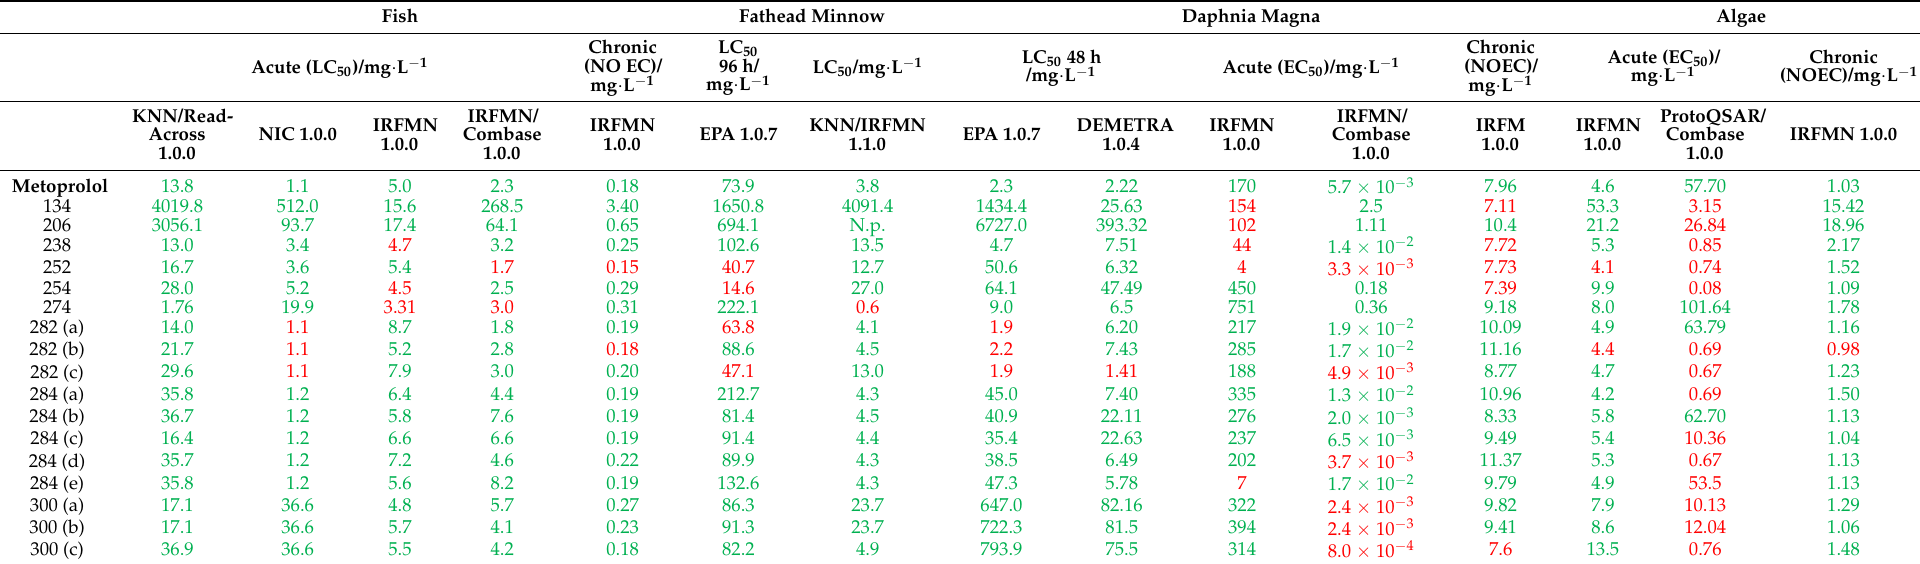
Table 5. QSAR analysis of metoprolol and its with less (green) and more hazardous (red) degradation and transformation products from UV irradiation and ozonation products using VEGA